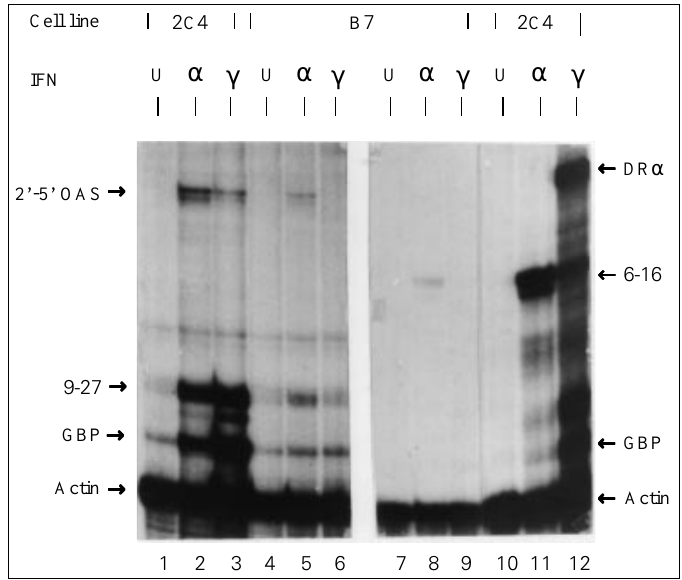
Figure 2 - IFN-stimulated gene expression in the parental cell line 2C4 and in the B7 mutant. The expression of 2(cid:146)-5(cid:146) oligo A synthetase (OAS), 9-27 and GBP (lanes 1-6), and class II HLA (DR a ), 6-16 and GBP (lanes 7-12) mRNAs in the parental cell line 2C4 and in the B7 mutant was investigated upon IFN- a or IFN- g treatment. Five hundred IU/ml of either IFN- a or IFN- g was added to the cells for 6 h and 18 h, respectively, cytoplasmic RNA was isolated (10 (cid:181)g per lane), hybridized with the specific probe and analyzed by the RNase protection assay as described in Material and Methods. g -Actin was used as an internal standard for RNA